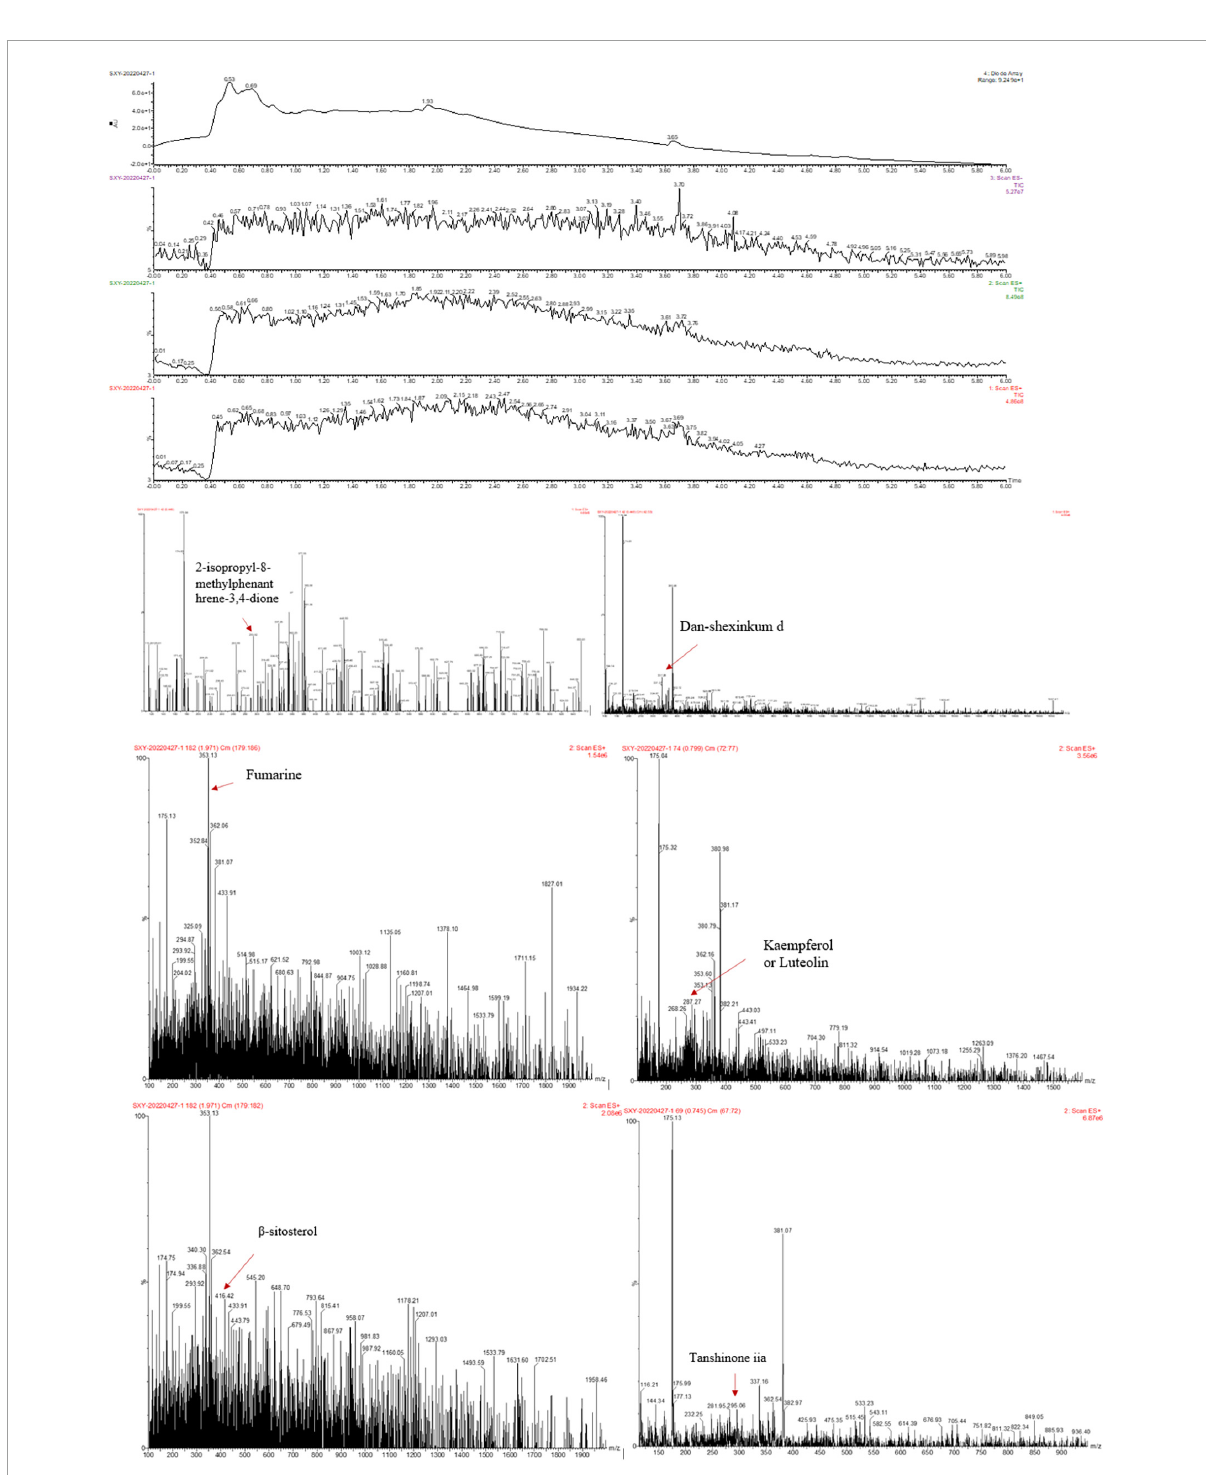
FIGURE1 The ingredients of Modified Linggui Zhugan Decoction (MLZD) were identified, and 7 active components were finally obtained.